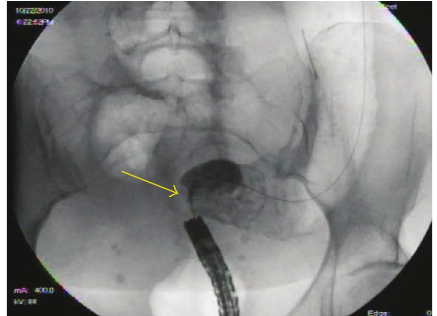
Figure 1: Colonoscopic view of splenic stricture (arrow) showing complete obstruction.